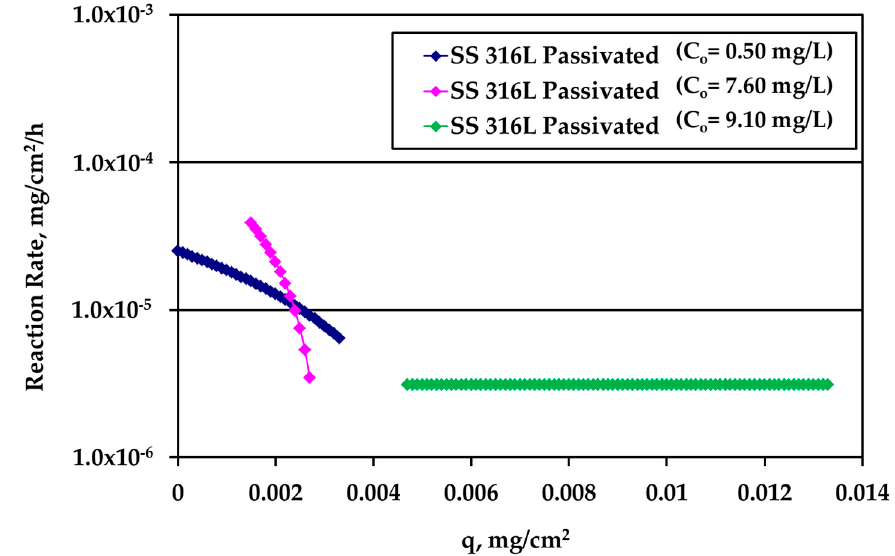
Figure 7. Reaction rate dependence on silver loading for passivated SS316L solid surface for various silver (bulk) concentration values.